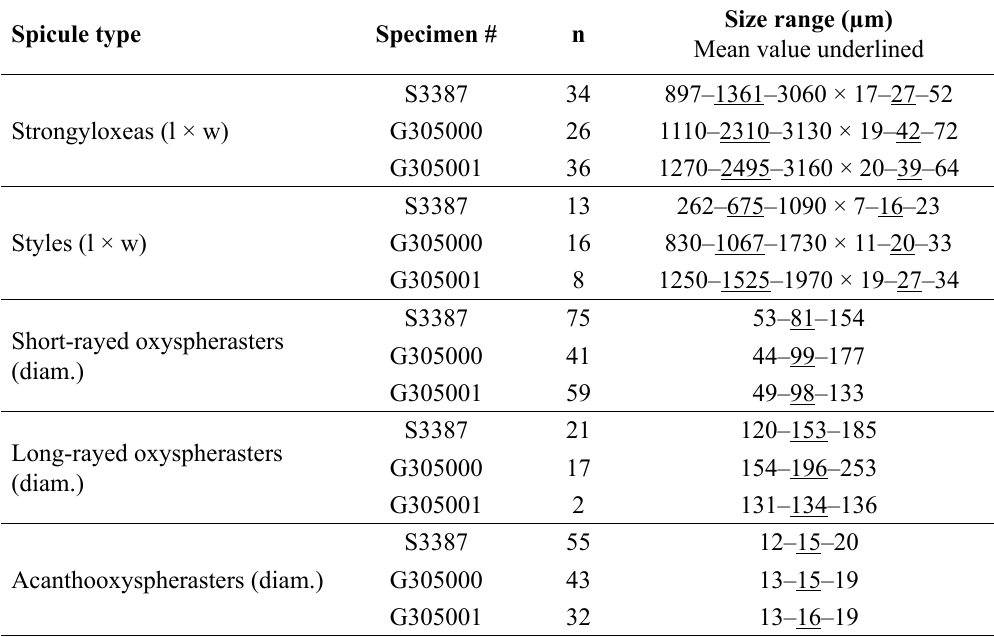
Table 1. Spicule dimensions of Tethya irisae sp. nov. holotype (SAMA S3387) and paratypes (QM G305000, QM